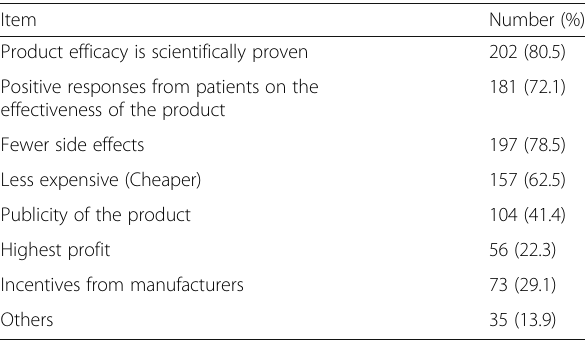
Table 9 Motivating factors reported by the participants toward recommendations for complementary and alternative medicine use